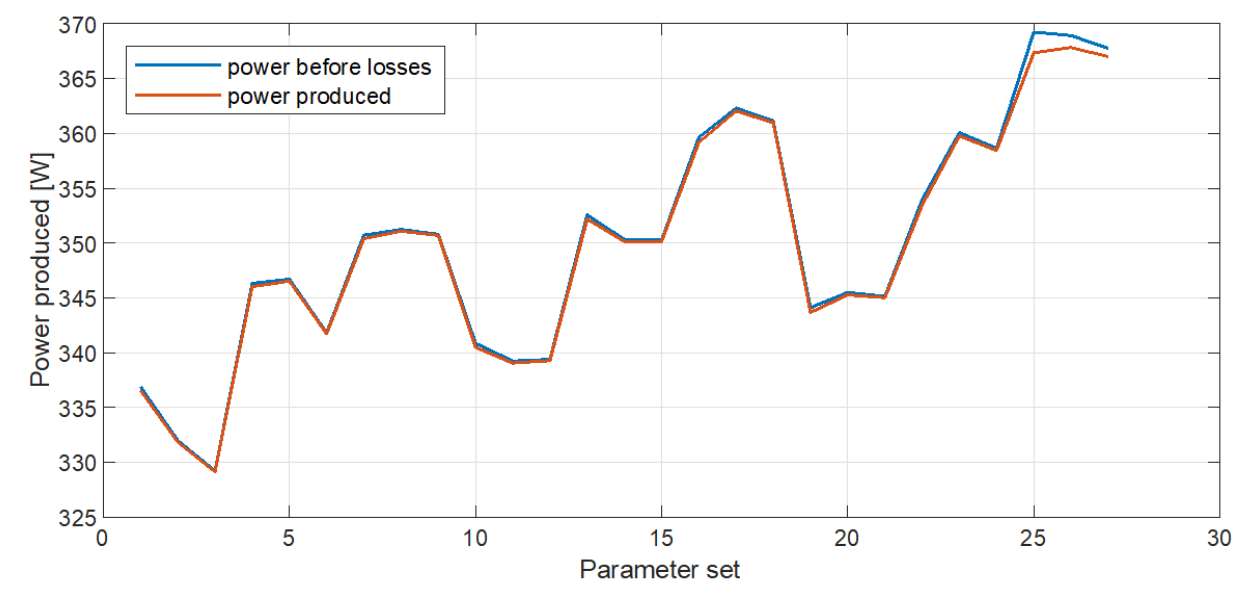
Figure 15. Full factorial parametric study results for power with and without losses.